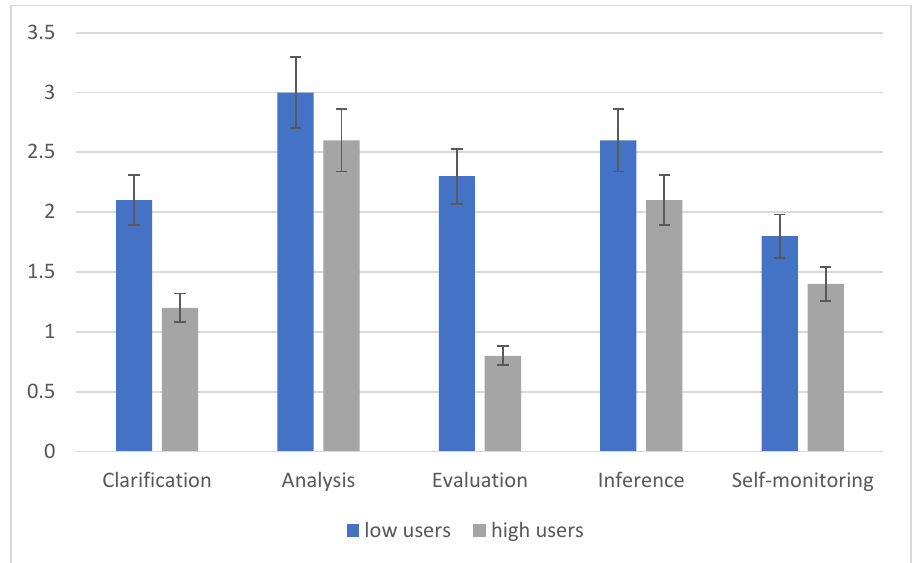
Figure 2. Means scores related to the phases of critical thinking of the mathematical problem.